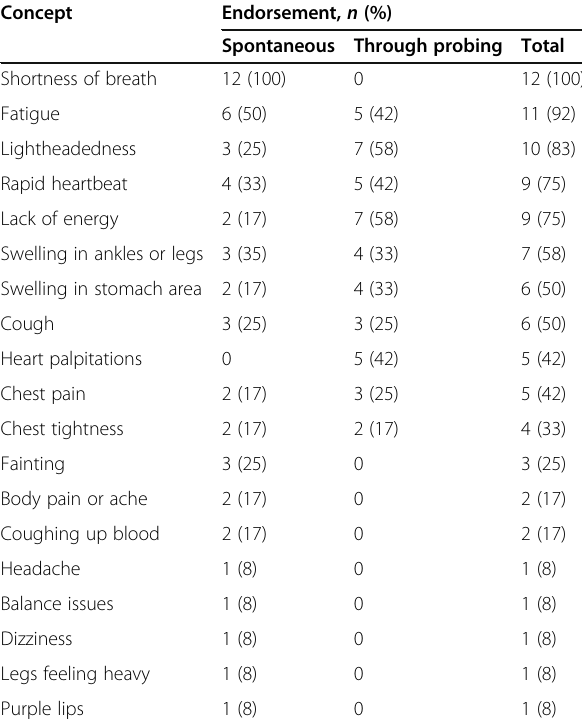
Table 2 Summary of endorsed symptom concepts Table 3 Summary of endorsed impact